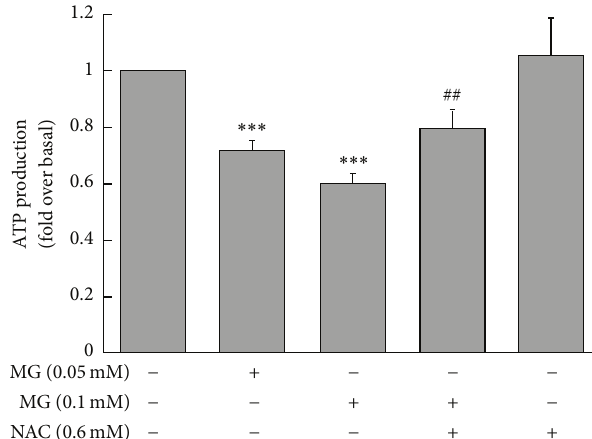
Figure 4: Effects of MG on the production of ATP by MIN6 cells. Reduction of ATP production by MG depended on MG concentration. The effects of MG were reversed by coincubation with NAC. ∗∗∗ 𝑝 < 0.001 compared to control group (0mM MG + 0 mM NAC). ## 𝑝 < 0.01 compared to the higher MG group (0.1mM MG + 0mM